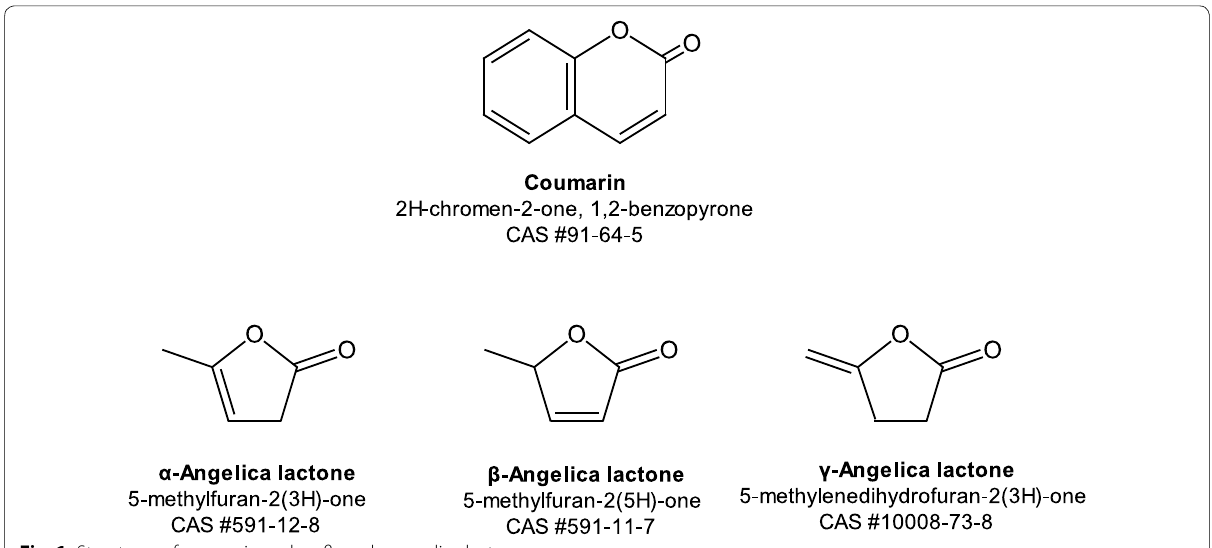
Fig. 1 Structures of coumarin and α-, β- and γ-angelica